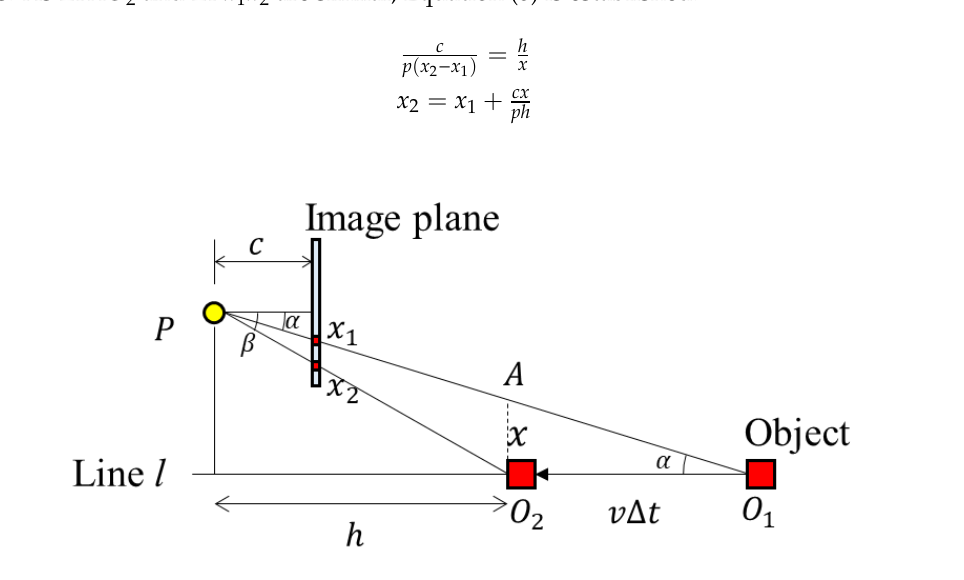
Figure 8. The RSE occurrence with the camera parameters and the moving scenario parameters (object moves back and forth).